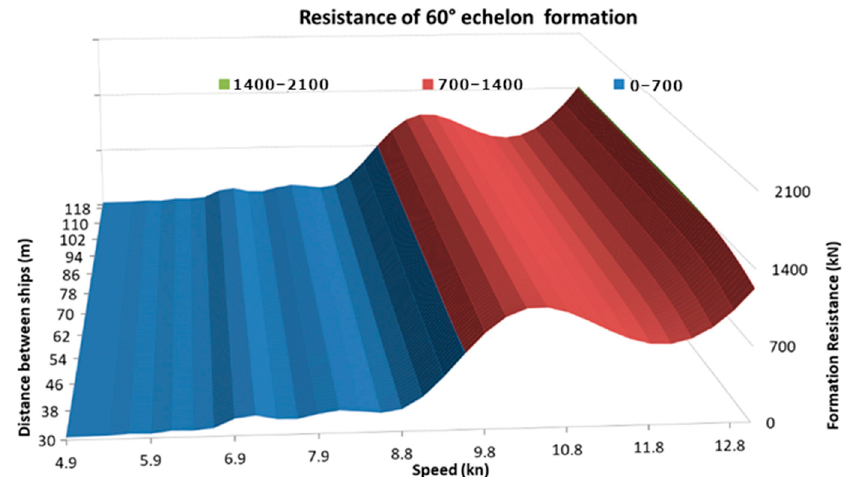
Figure 11. Total resistance of a formation consisting of four tugboats sailing in an echelon formation with an angle of 60 ◦